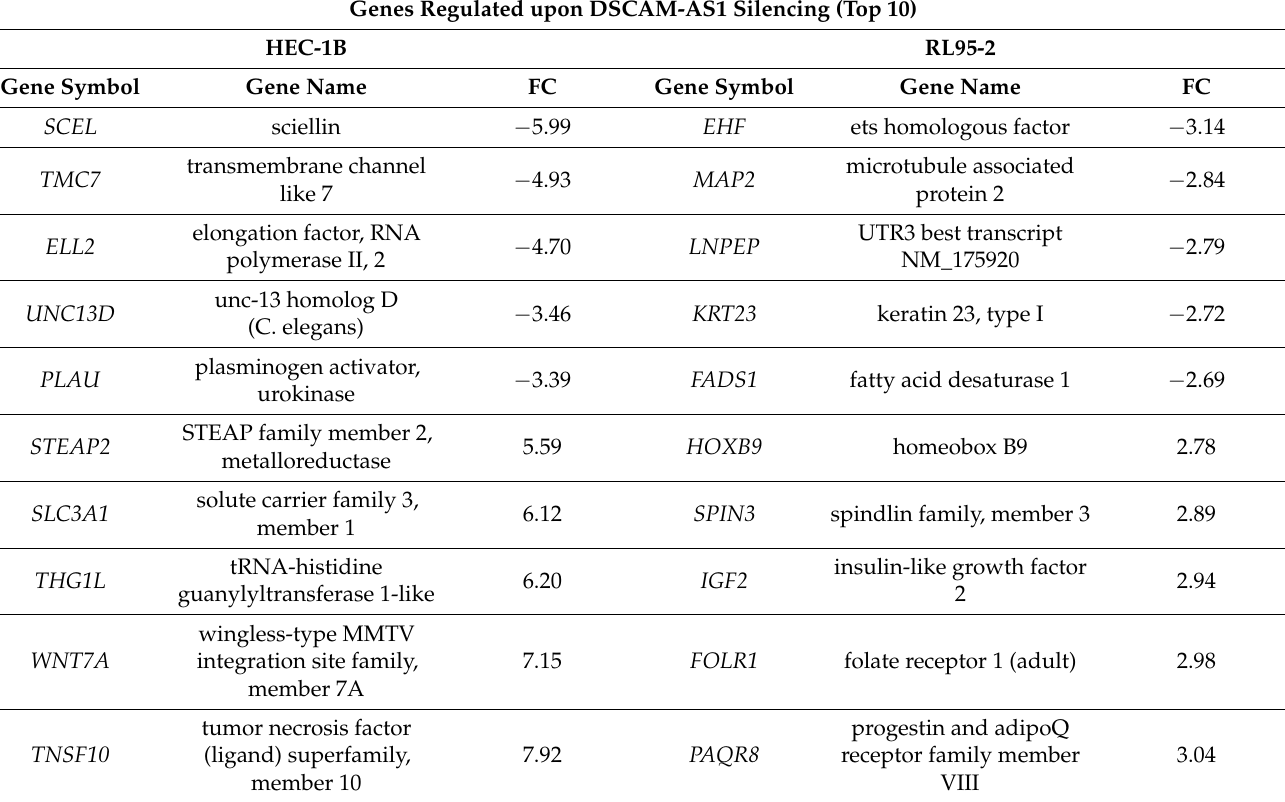
Table 2. Top 10 regulated genes after RNAi-mediated knockdown of DSCAM-AS1 in HEC-1B and RL-95-2 cells ( p < 0.05). The knockdown efficacy differed between both cell lines due to ER α -triggered DSCAM-AS1 upregulation in RL95/2 cells. FC = fold-change. Genes Regulated upon DSCAM-AS1 Silencing (Top 10) HEC-1B